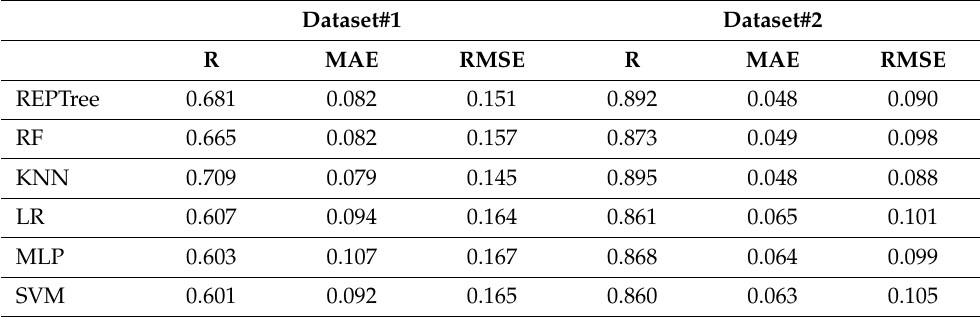
Table 3. Regression analysis results for the normalized LCOM2 metric after removing outliers and extreme